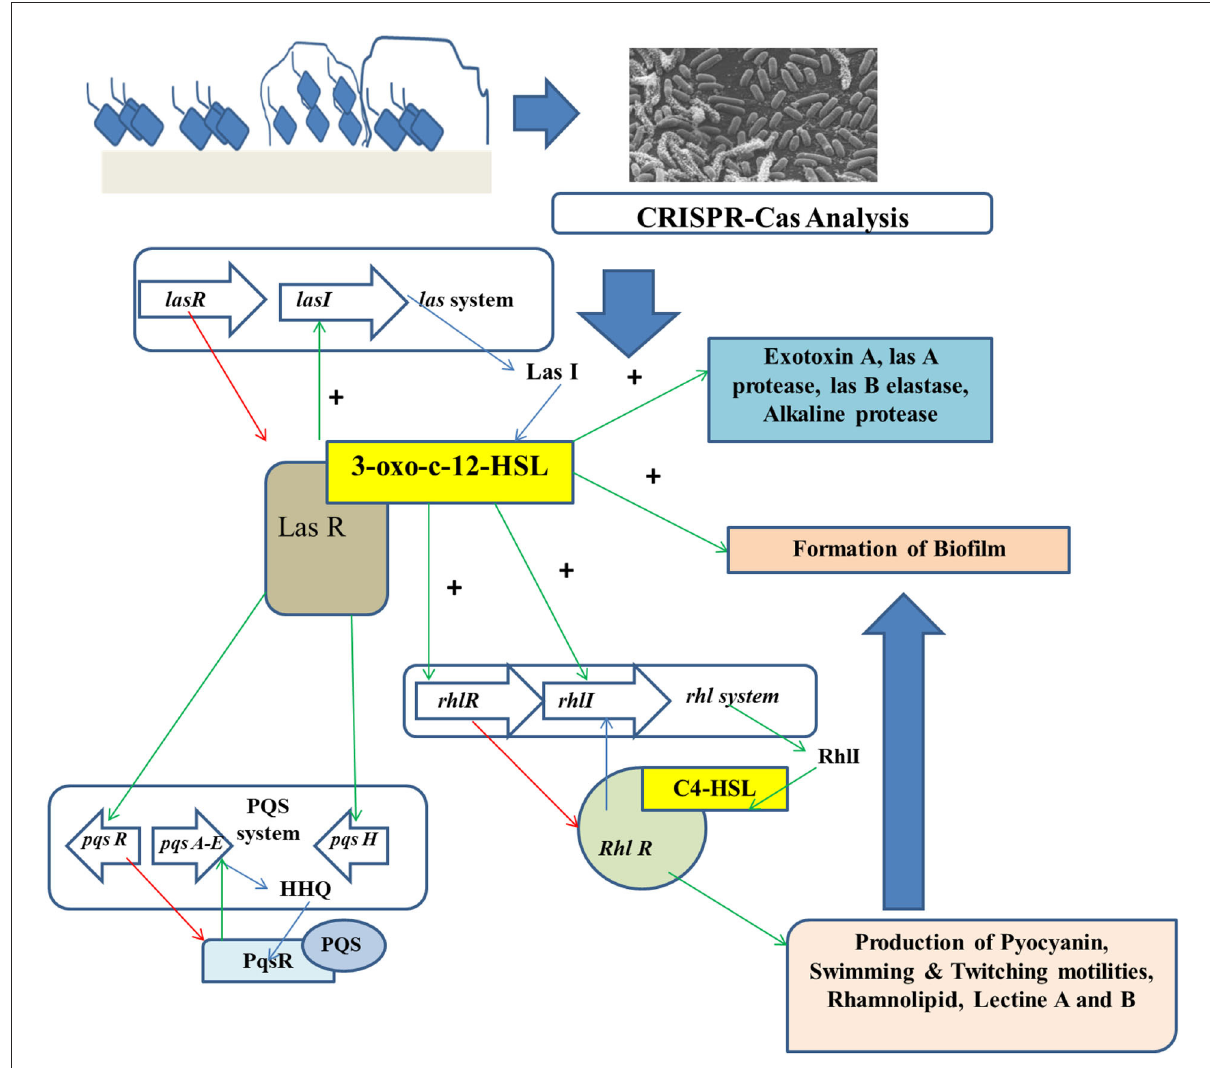
FIGURE3 CRISPR-Cas analysis for preventing the growth of foodborne biofilm-producing